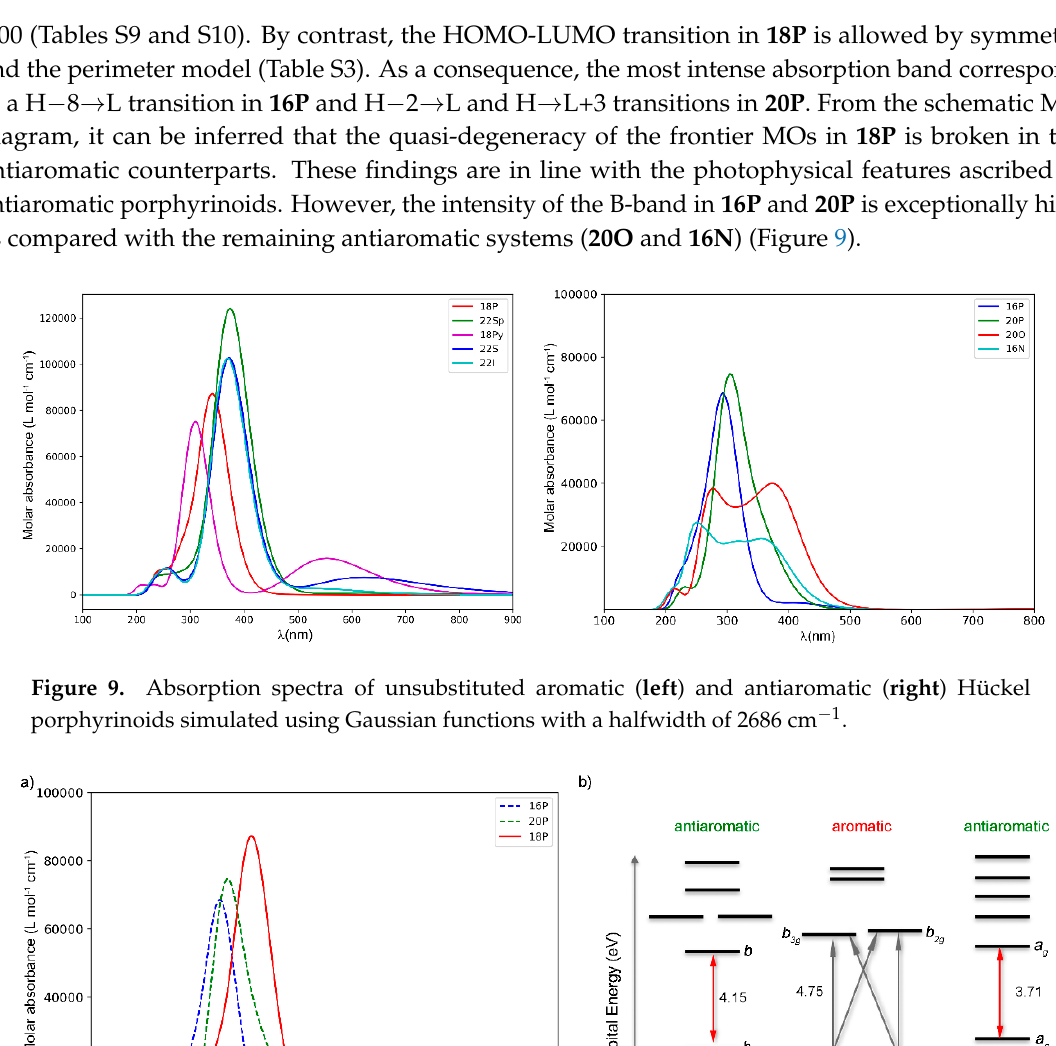
Figure 8. Molecular orbitals for aromatic and antiaromatic Hückel porphyrinoids: ( a ) (16)norcorrole, ( b ) (18)porphyrin, ( c ) (20)orangarin, ( d ) (22)smaragdyrin. The values in red indicate the number of nodal planes in each orbital.